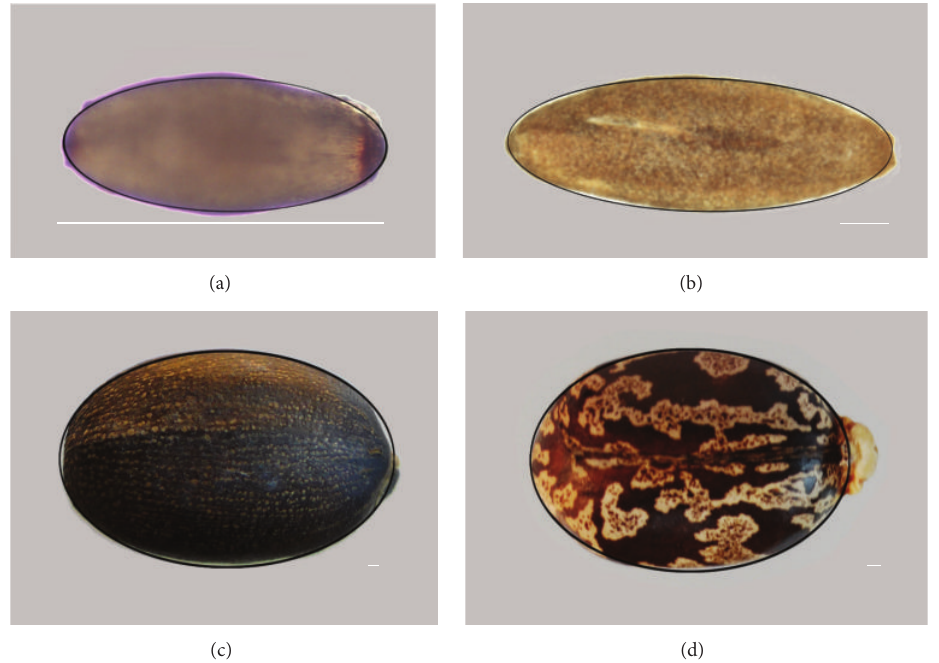
Figure 5: Seed shape models based on ellipses may be used for Campanulaceae and Apocynaceae ((a) Campanula dichotoma L.; (b) Nerium oleander L.) and have been applied in the description of Euphorbiaceae seeds ((c) and (d) correspond to seeds of Jatropha curcas L. and Ricinus communis L.). Scale bar represents 0.5 mm.